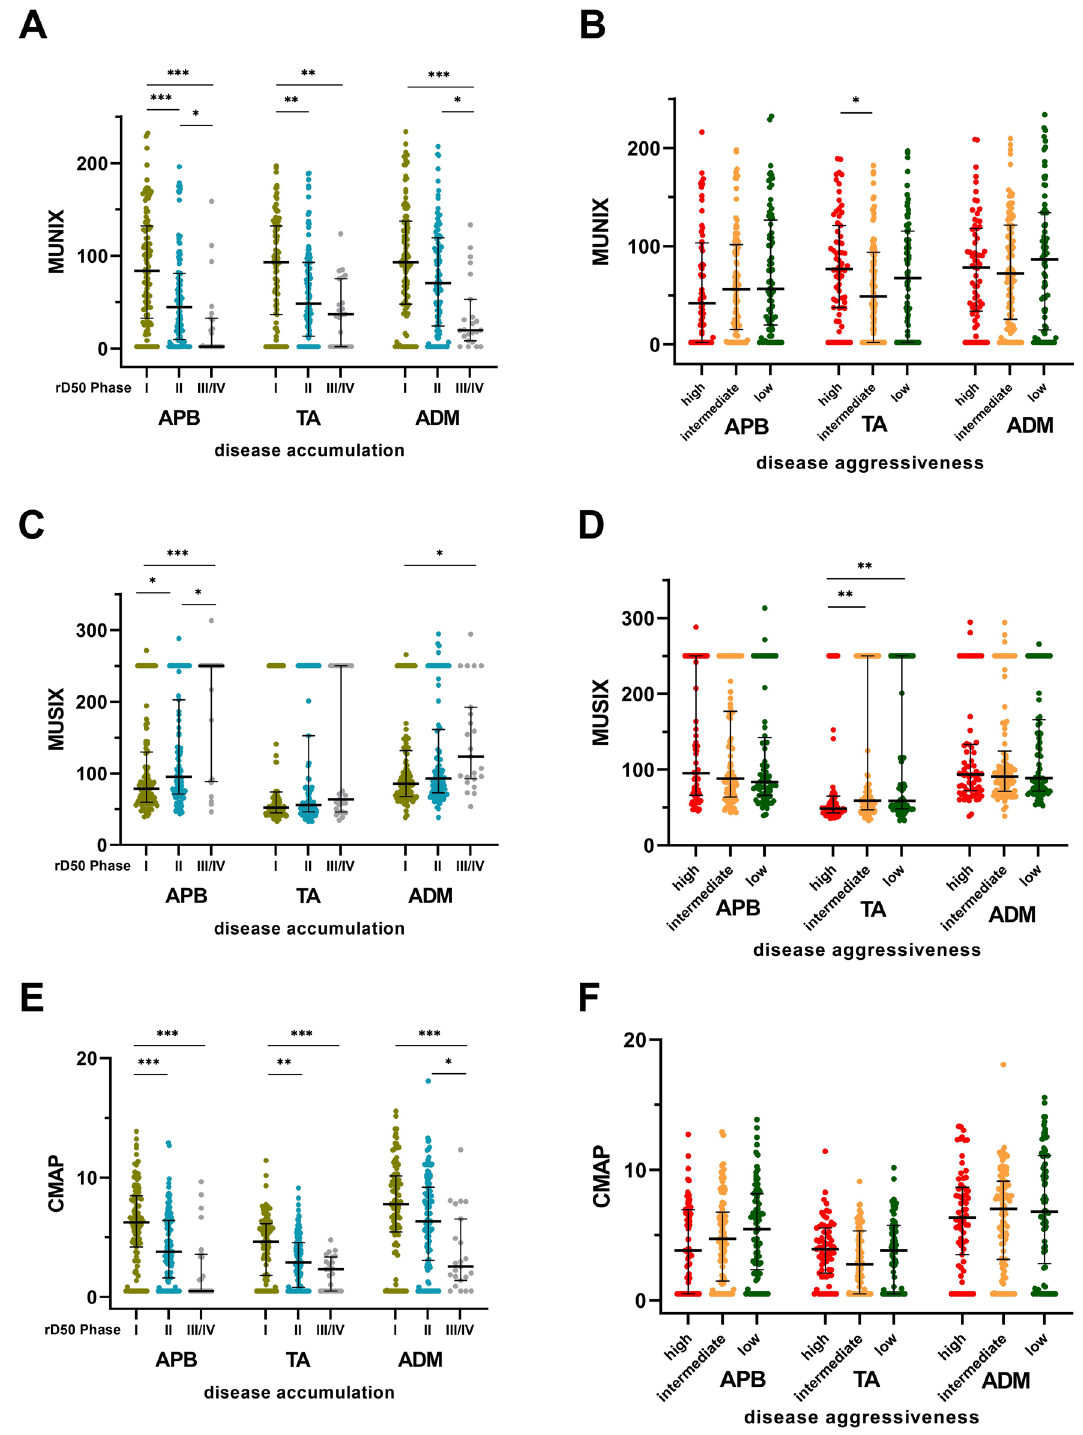
Figure 2. Scatterplots of the ALS cohort of MUNIX ( A,B ), MUSIX ( C,D ) and CMAP ( E,F ) divided for each muscle into three groups based on: ( A,C,E ) rD50 phases: the early semistable Phase I (0 ≤ rD50 < 0.25, in green), the early progressive Phase II (0.25 ≤ rD50 < 0.5, in blue), and the late progressive and stable Phase III/ IV (rD50 ≥ 0.5, in gray). ( B,D,F ) High (0 ≤ D50 < 20 months, in red), intermediate (20 ≤ D50 < 40, in yellow) and low (D50 ≥ 40, in green) disease aggressiveness. *p < 0.05, **p < 0.01, ***p < 0.001. Comparisons with Kruskal– Wallis test, pairwise comparisons with Bonferroni correction. Bars indicate median and interquartile range. ADM abductor digiti minimi, APB abductor pollicis brevis, CMAP compound muscle action potential (in mV), MUNIX motor unit number index, MUSIX motor unit size index, TA tibialis